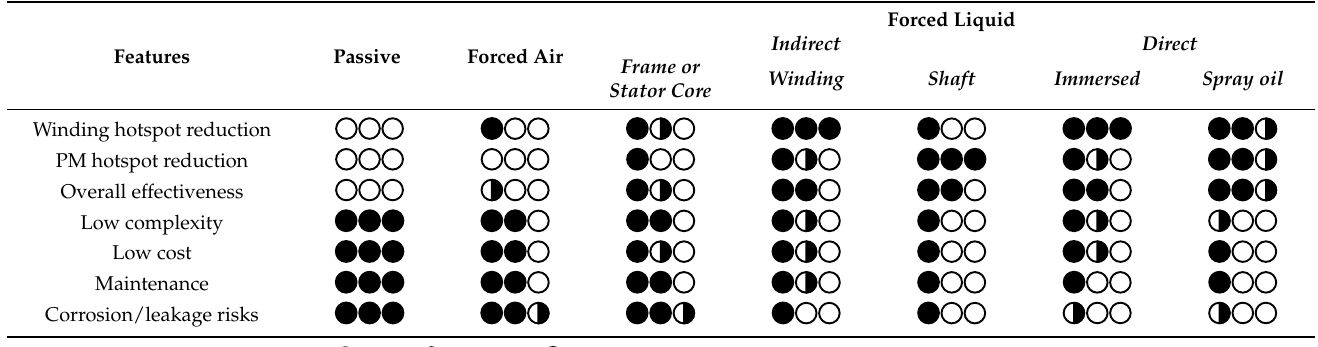
(b) Figure 13. Direct forced liquid cooling. ( a ) Stator immersion. ( b ) Spray cooling (three oil inlets on either side could be assembled separately). In contrast, spray oil cooling, which is pure convection heat exchange, is favourable due to its high stability and electrical insulation [174], and has also been employed in a Toyota Prius HEV in 2017 [172]. As can be seen from Figure 13b, the spray oil inlets could be located in the frame, the end-cap, or the shaft. The spray cooling is essentially based on the enhanced convection heat transfer between the sprayed cool oil with the end surfaces of end-winding and PM. In [173,175], the influences of oil flow rate, pressure, and the number of nozzles on the cooling efficiency, as well as the CHT coefficient, are investi- gated. However, it needs to be mentioned that the design of spray oil cooling is complex and exhibits large uncertainty, and the local hotspots in the end-winding may still exist.